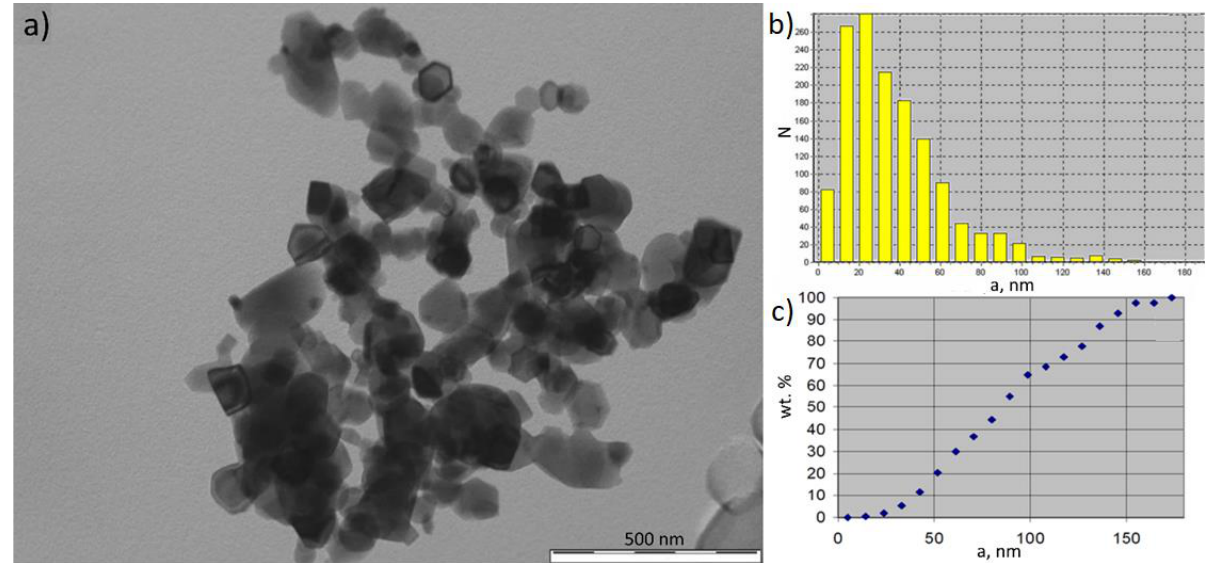
Figure 3. TEM image of AlN nanoparticles ( a ), histogram of particle size distribution ( b ) and integral curve mass distribution of particles ( c ).